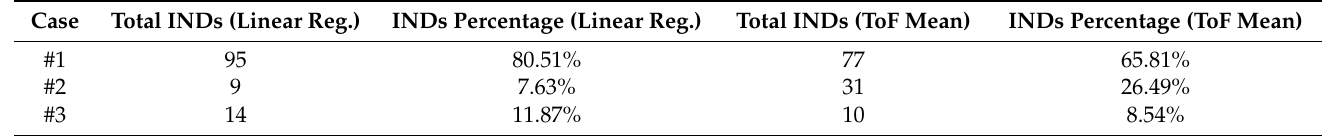
Table 3. Auto depth measurement relative accuracy based on the A-Scans with the maximum depth in each